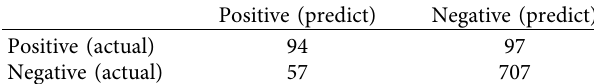
Table 15: Confusion matrix of the high precision data set.